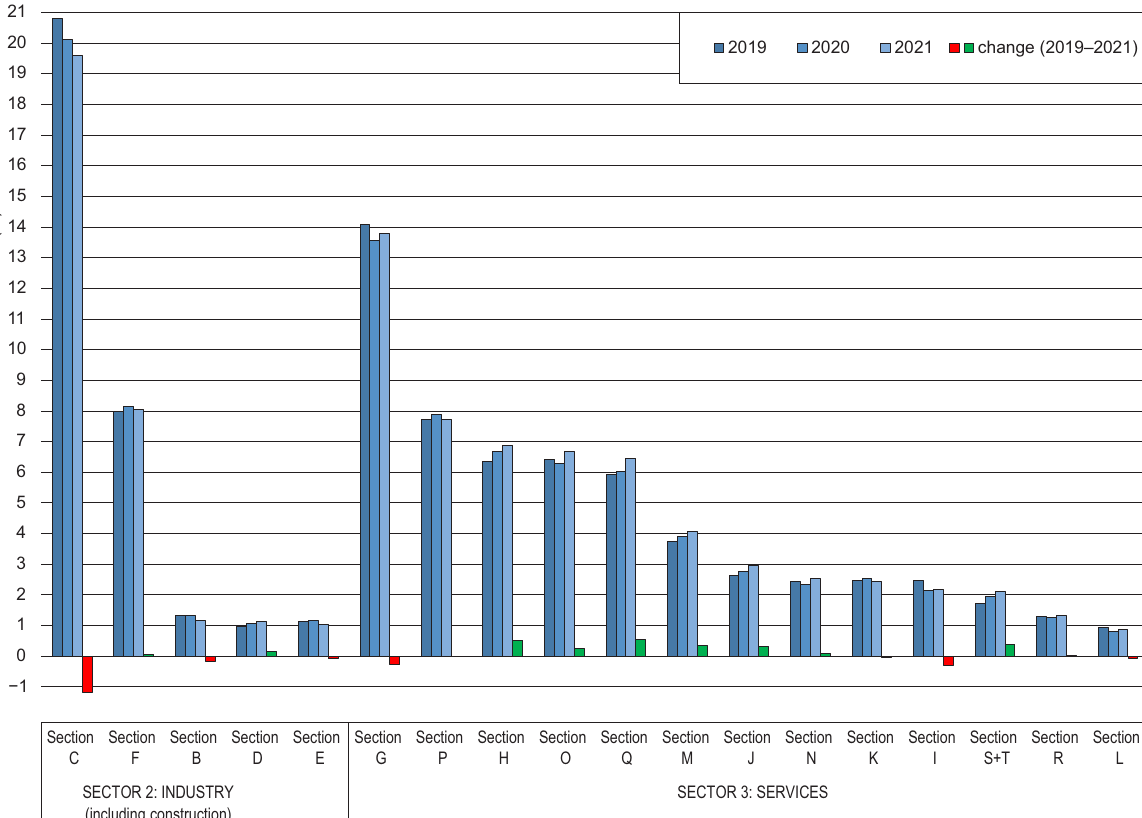
Fig. 3. Changes in the employment structure of industry and services sectors by section in the years 2019–2021 in